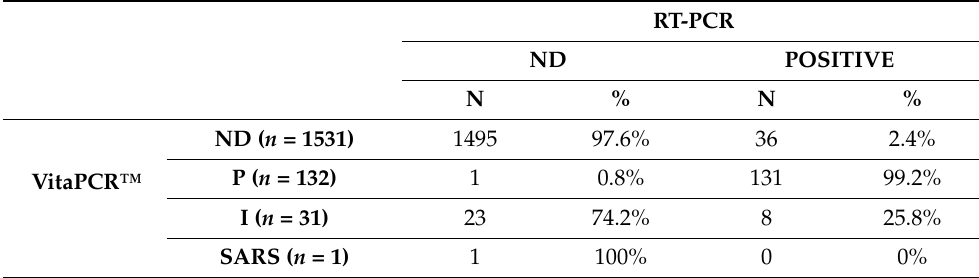
Table 2. VitaPCR™ results in comparison with the gold standard